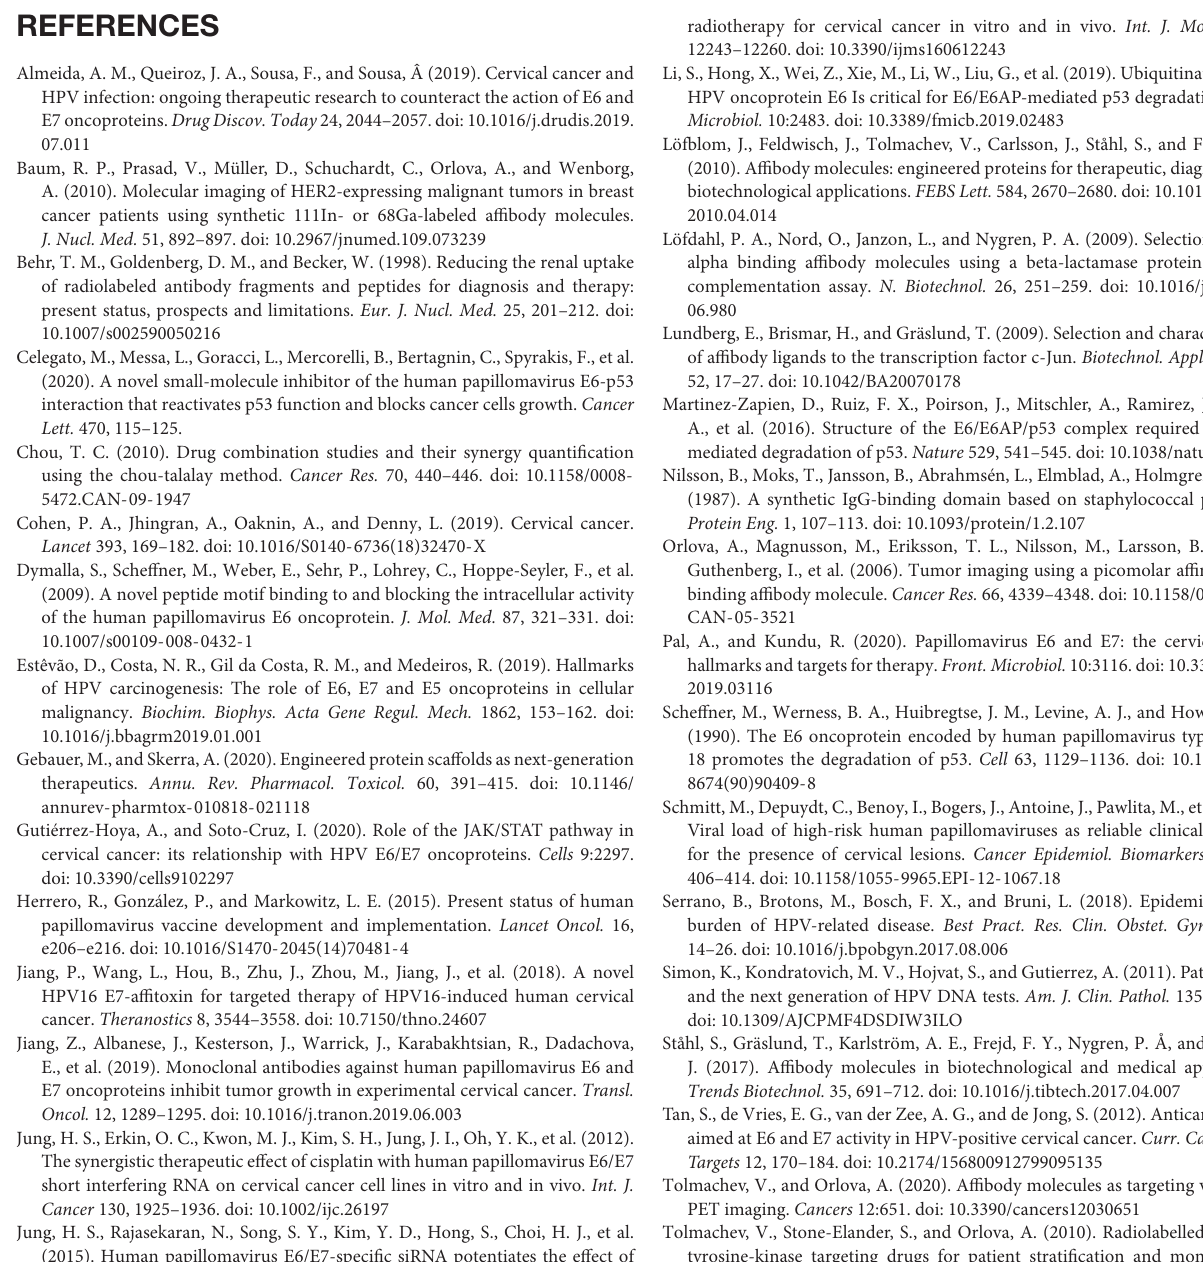
Supplementary Figure 1 | ELISA screening for target-binding activity of potential HPV16 E6-binding affibody molecules from 66 clones. Supplementary Figure 2 | Amino acid sequence of the wild-type Z domain aligned to amino acid sequences of 42 unique affibody variants showing binding